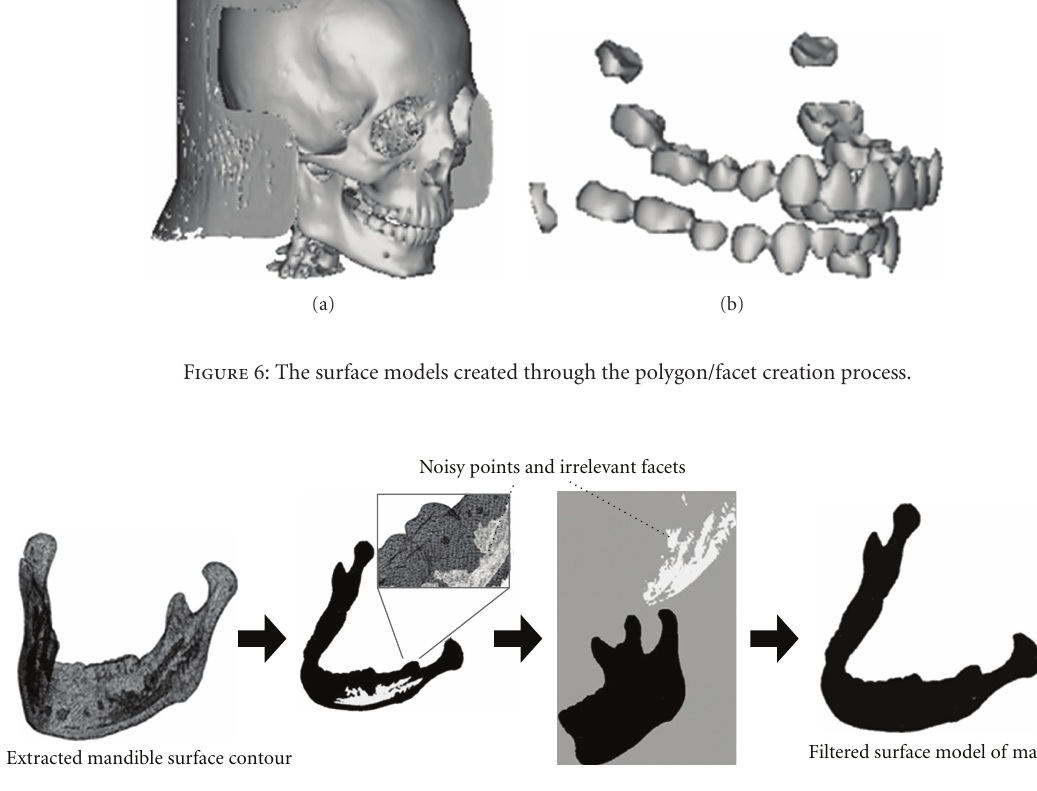
facets. Similarly, the surface contours of enamel, dentin, and pulp were also extracted and